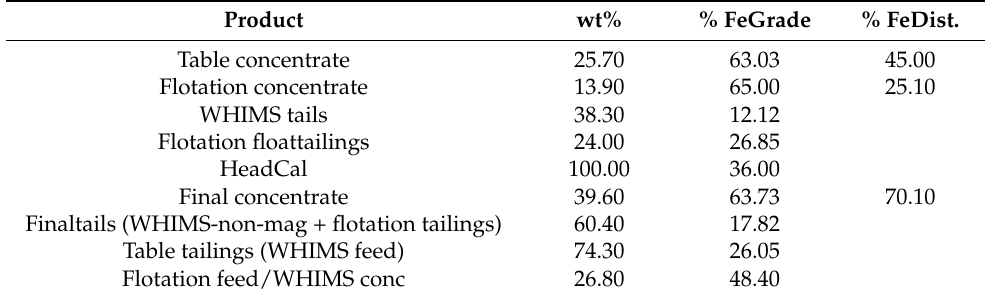
Table 9. Final conventional process flowsheet